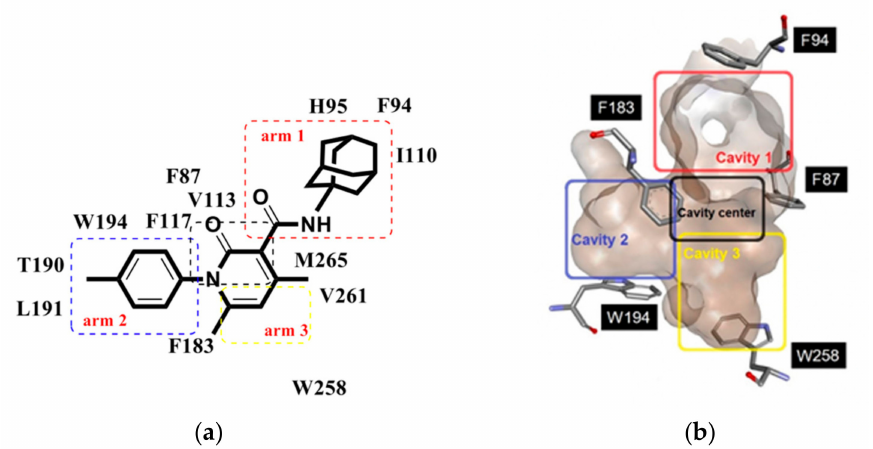
Figure 3. ( a ) Compound 8d interacting with residues of the binding pocket in the CB2R. The three arm-structure and residues from the three cavities are shown; ( b ) CB2R binding pocket with the three main cavities